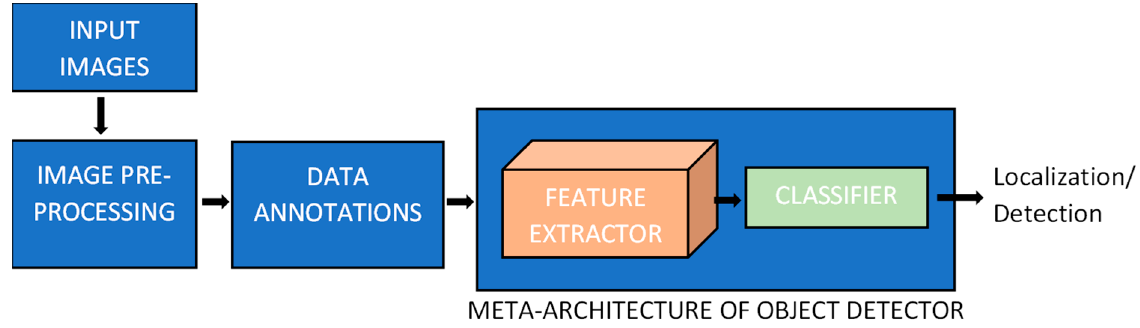
Figure 5. The Overall